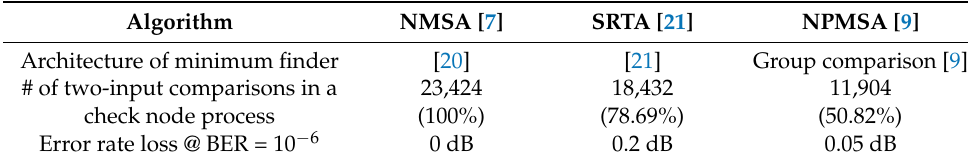
Table 1. Comparison of check node processes in different algorithms.